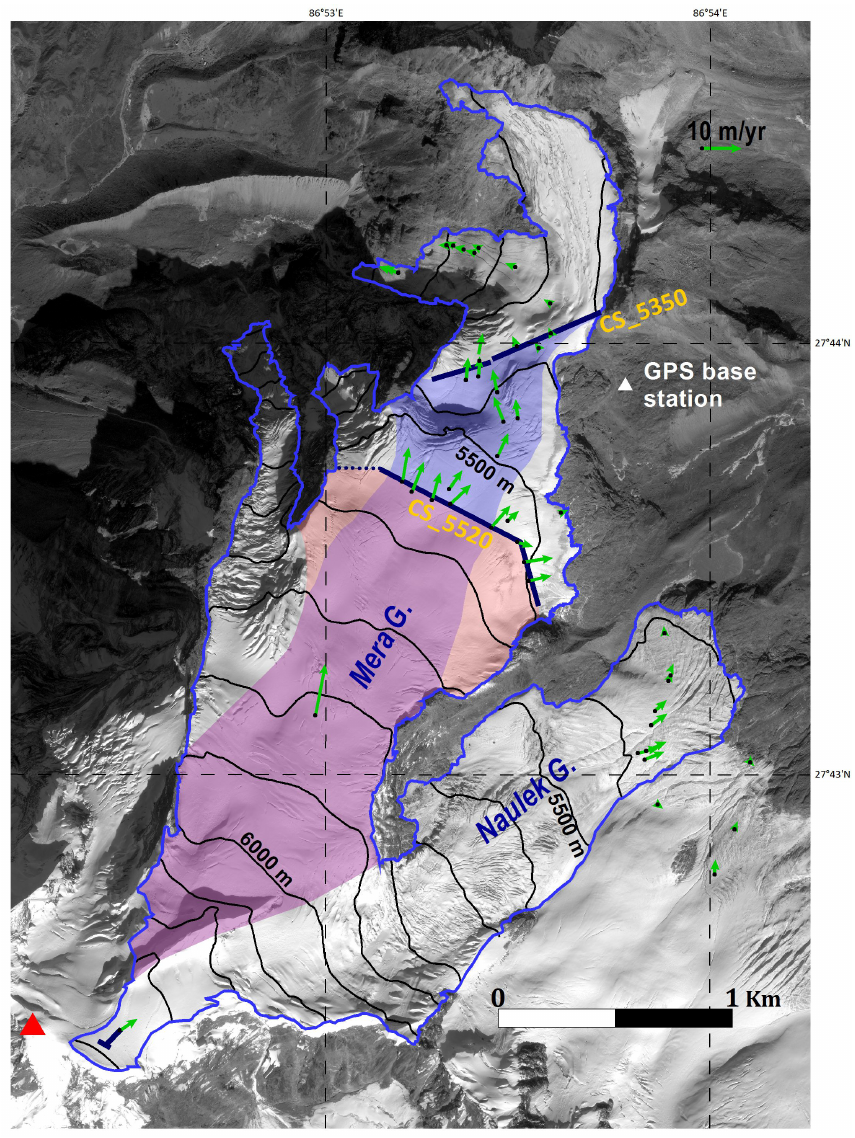
Fig. 9. Map of Mera Glacier showing mean annual surface velocities measured during the period 2007–2012 (green vectors). All DGPS measurements have been averaged, and the number of measuring years used to obtain annual velocities varies from 1 (1 single year of measurements) to 5 (the full period), depending on the survival time of the stakes. The blue line is the glacier outline, and the dark blue short segments are GPR survey cross sections that have been measured in the field in November 2009 (CS_5520 and CS_5350 at 5520 and 5350ma.s.l. respectively) and in November 2012 (at 6350ma.s.l.). The dashed part of CS_5520 on the left bank of the glacier corresponds to the unsurveyed interpolated part of the section. Transparent blue and pink areas are the areas feeding CS_5350 and CS_5520 respectively (with a mixed purple colour when these areas are overlapping). Background: 25 November 2012 Pleiades-1A image (CNES 2012/Distribution